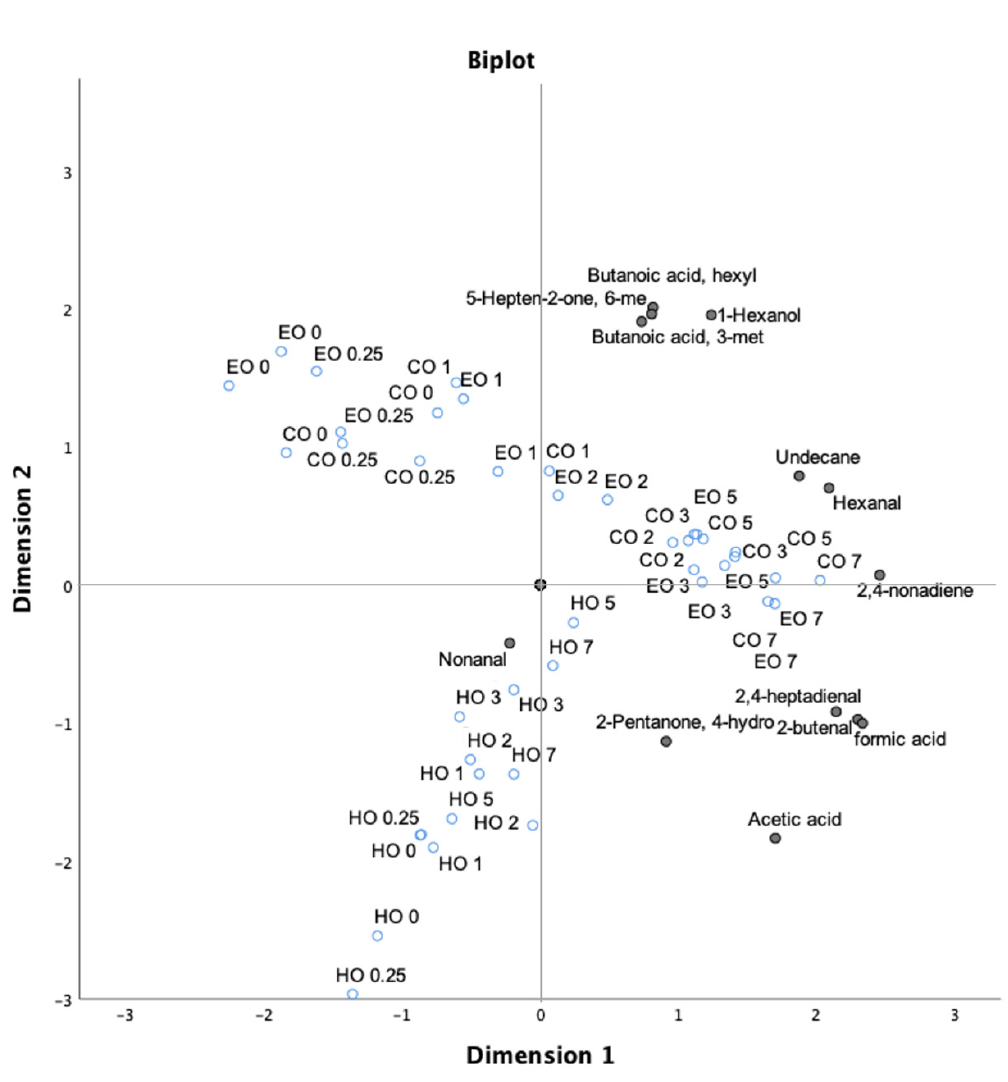
Figure 6. Bi-plot of volatile compounds (black circles), excluding the terpenoid compounds, and treatment time (empty blue circles) in thermo-oxidized bulk oils (stripped linseed oil without antioxidants (CO), with hemp extract (HO), and with α -tocopherol (EO)).